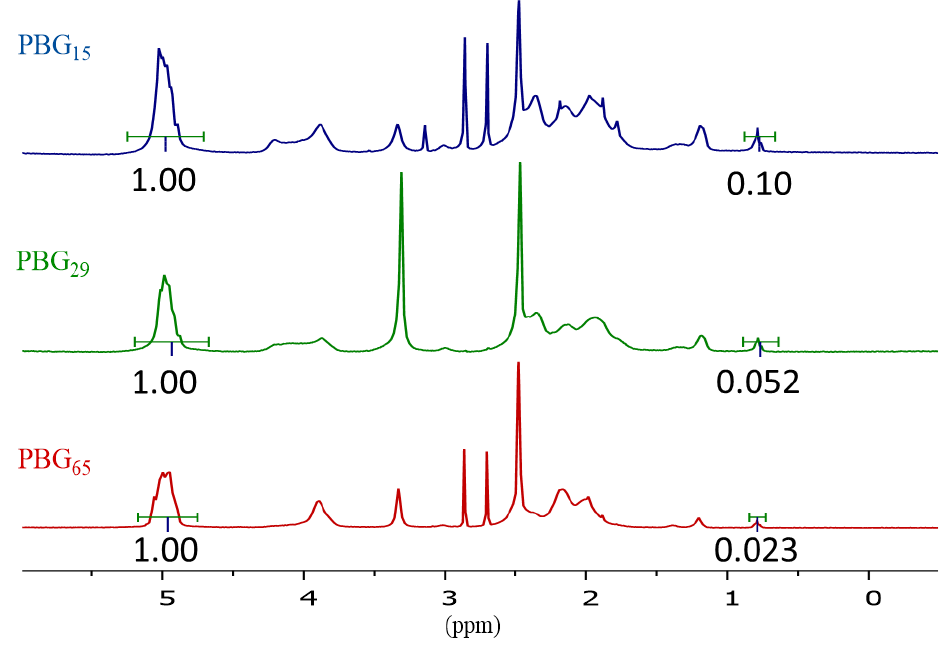
Figure 1. Comparison of 1 H NMR spectra for the different linear PBG samples in DMSO- d 6 .